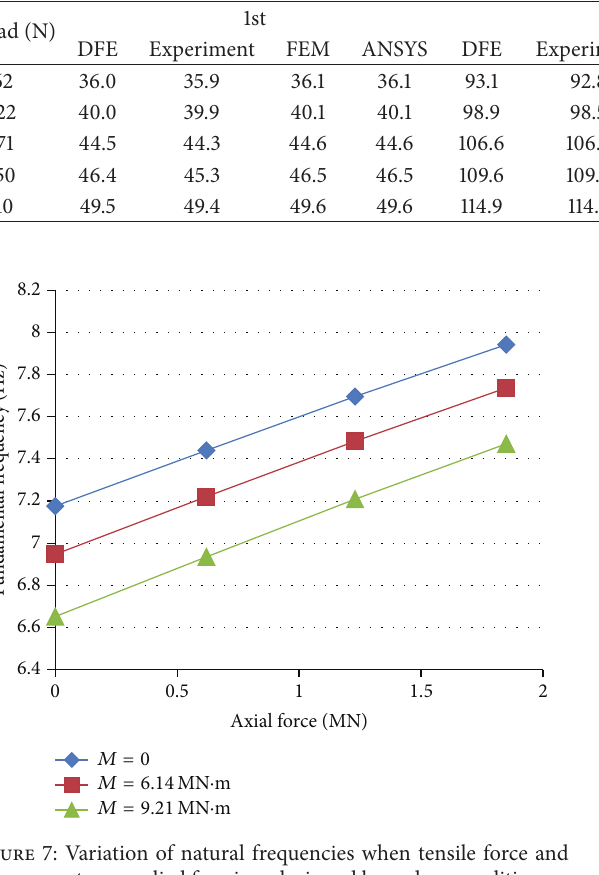
Figure 9: Variation of critical buckling end moment ( 𝑀 𝑧𝑧 axial force (𝑃) for cantilevered boundary